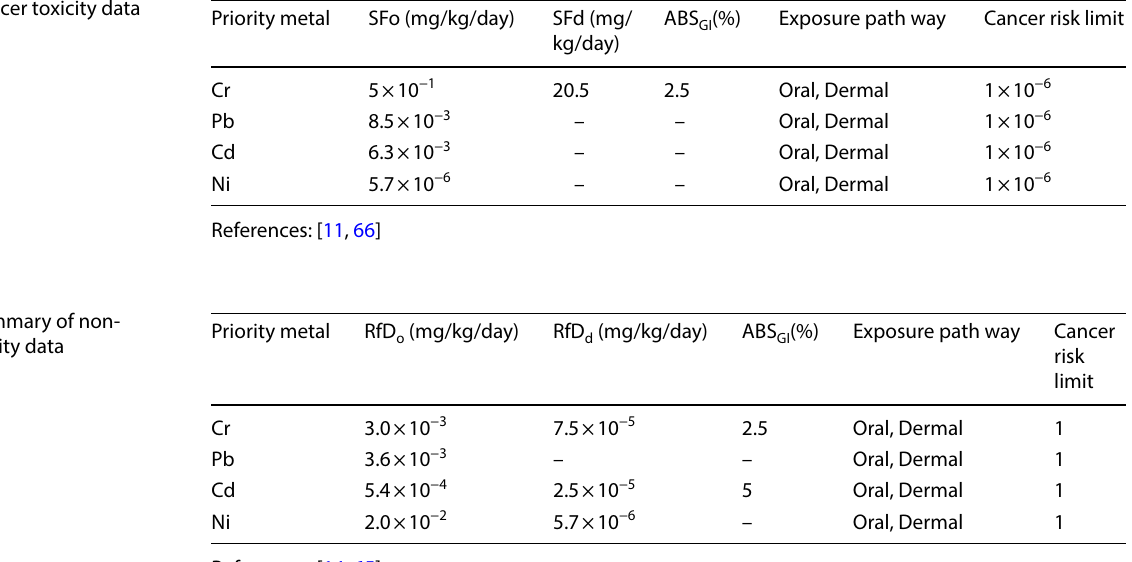
Table 5 Cancer toxicity data